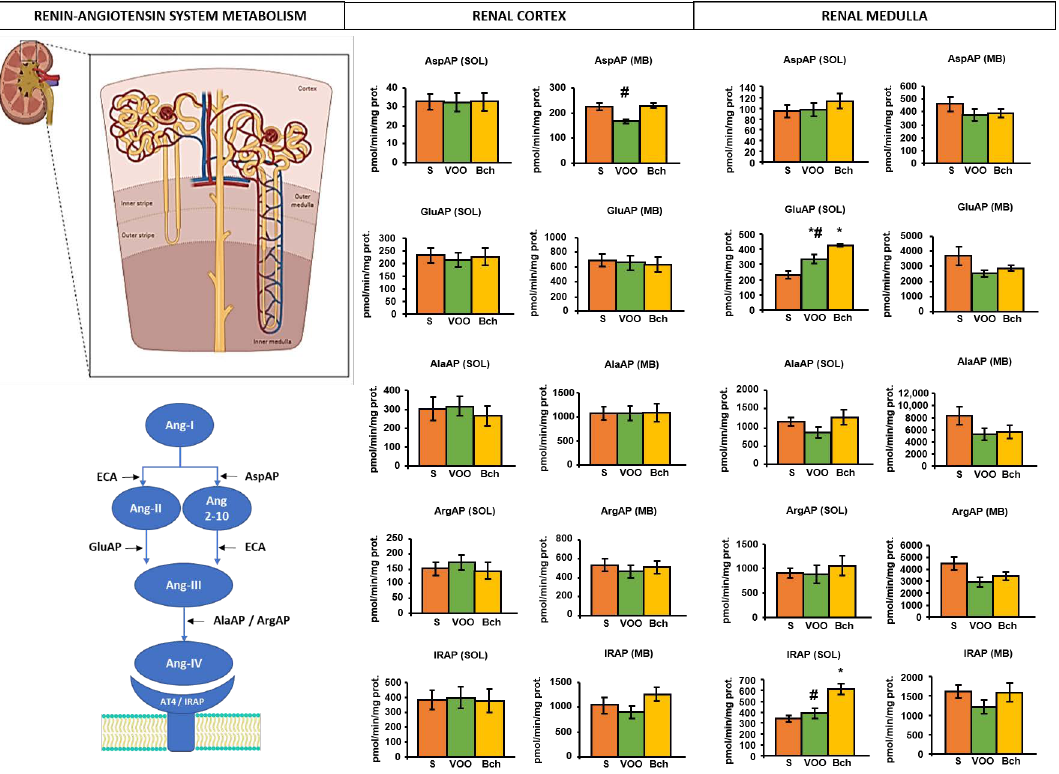
Figure 2. Anatomical representation of the renal parenchyma and partial scheme of the classic axis of the renin–angiotensin system, displaying the metabolic steps in which angiotensinase activities are involved. Mean values ± standard errors of aspartyl-, glutamyl-, alanyl-, arginyl- and insulin-regulated aminopeptidase activity (AspAP, GluAP, AlaAP, ArgAP, IRAP) in soluble (SOL) and membrane-bound (MB) fractions of renal cortex and medulla. Values are expressed as pmol/min/mg prot. * indicates significant differences between VOO or Bch vs. S, * p < 0.05. # indicates significant differences between VOO and Bch, # p <